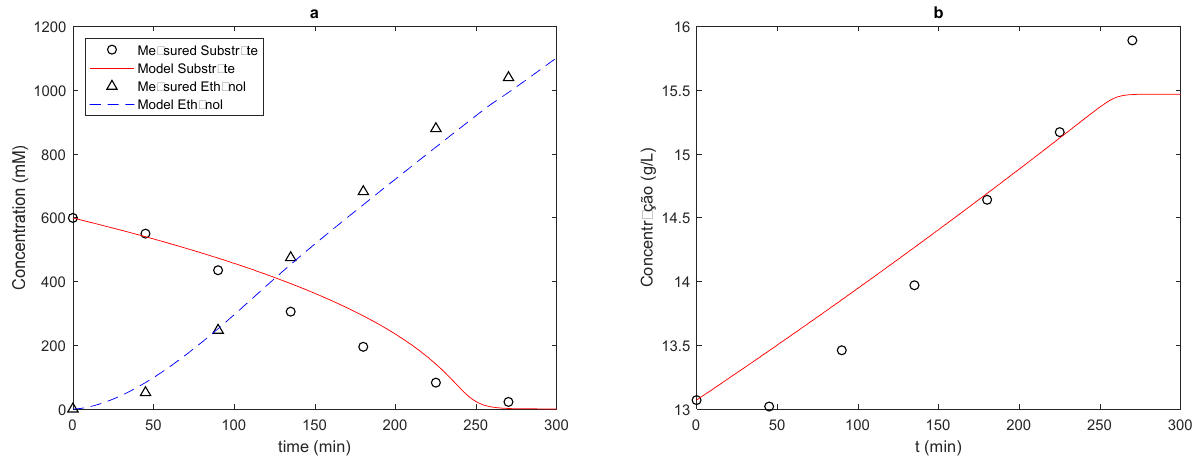
Figure 7. ( a ) Result of the CR model with an initial concentration of 100 g/L, and ( b ) adjustment of cell concentration. Source: prepared by the author.